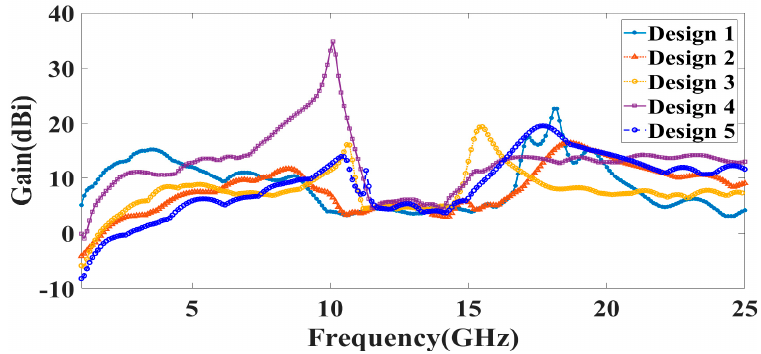
Figure 6. Measured values of the gain for the di ff erent antenna designs for the frequency range of 1 to 25 GHz.